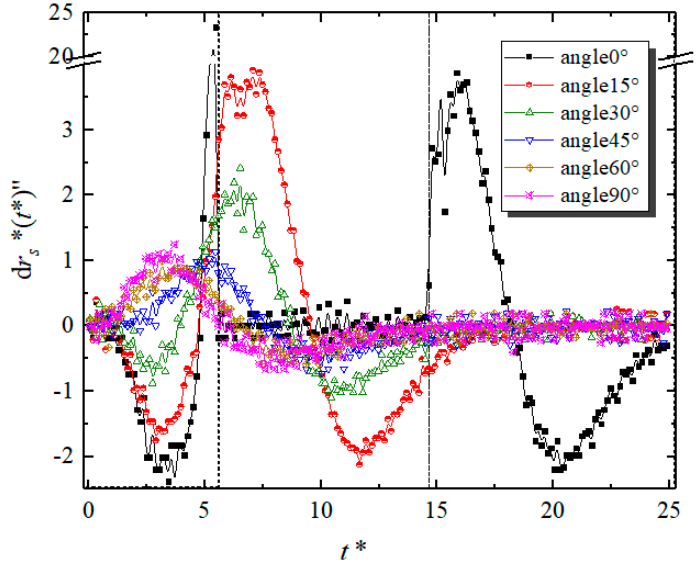
Figure 14. The second-order derivative of surface-to-surface distance to time as functions of time.